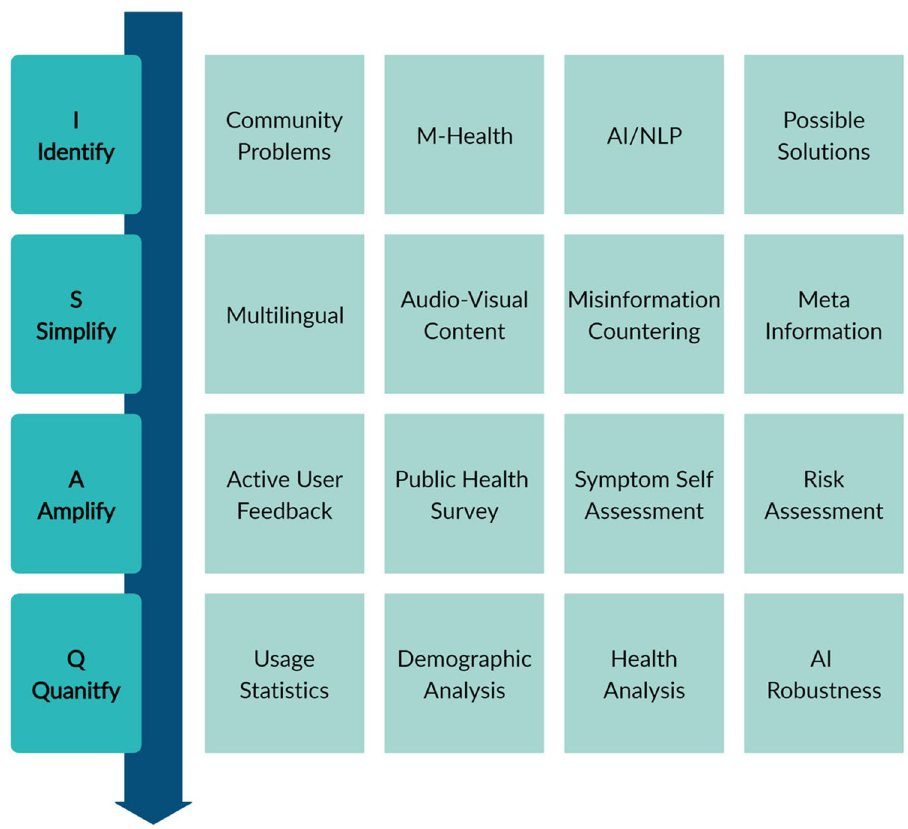
Figure 1. Proposed workflow of the App based upon Identify, Simplify, Amplify and Quantify framework as specified WHO’s EPI-WIN strategy 4